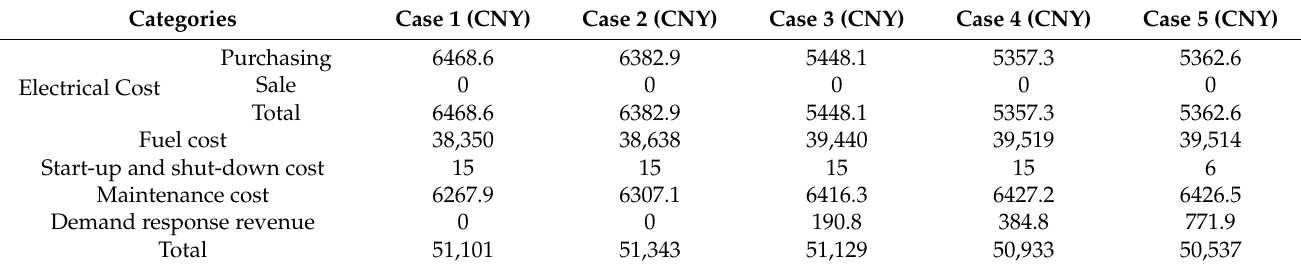
Table 7. The operating results considering different demand respond